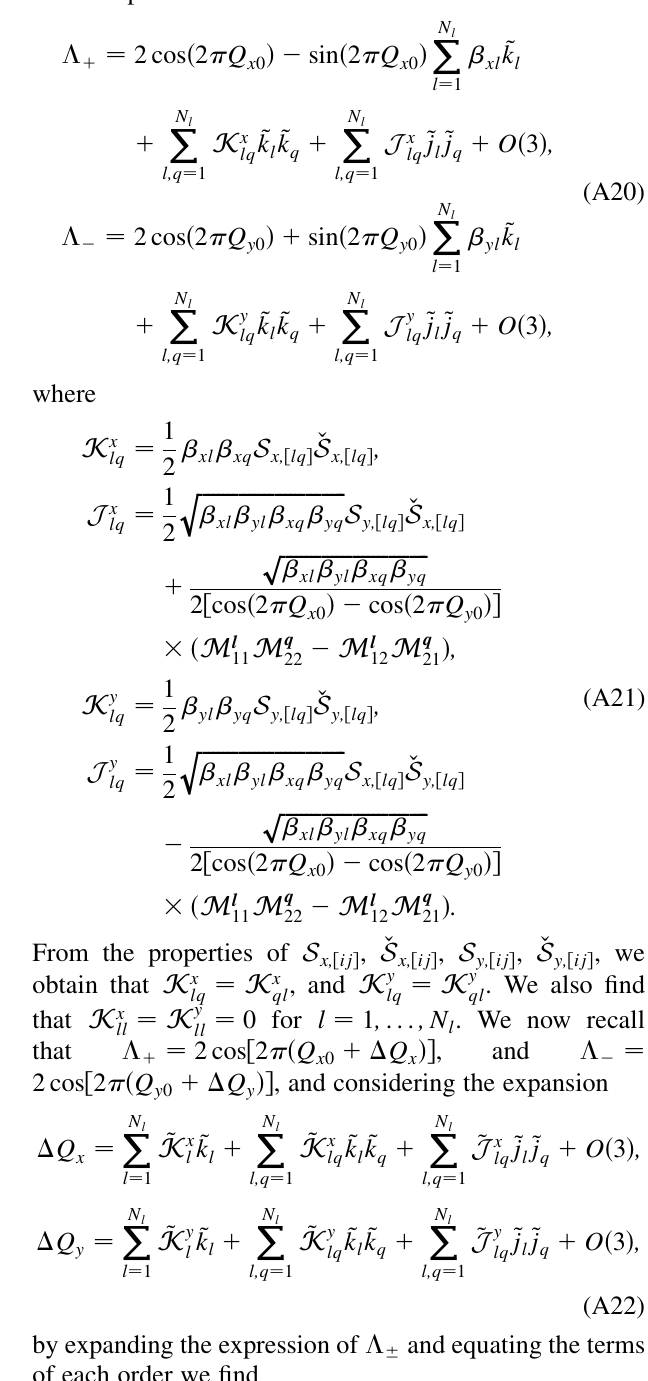
ffiffiffiffiffiffiffiffiffiffiffiffiffiffiffiffiffiffiffiffiffiffiffiffiffiffiffi